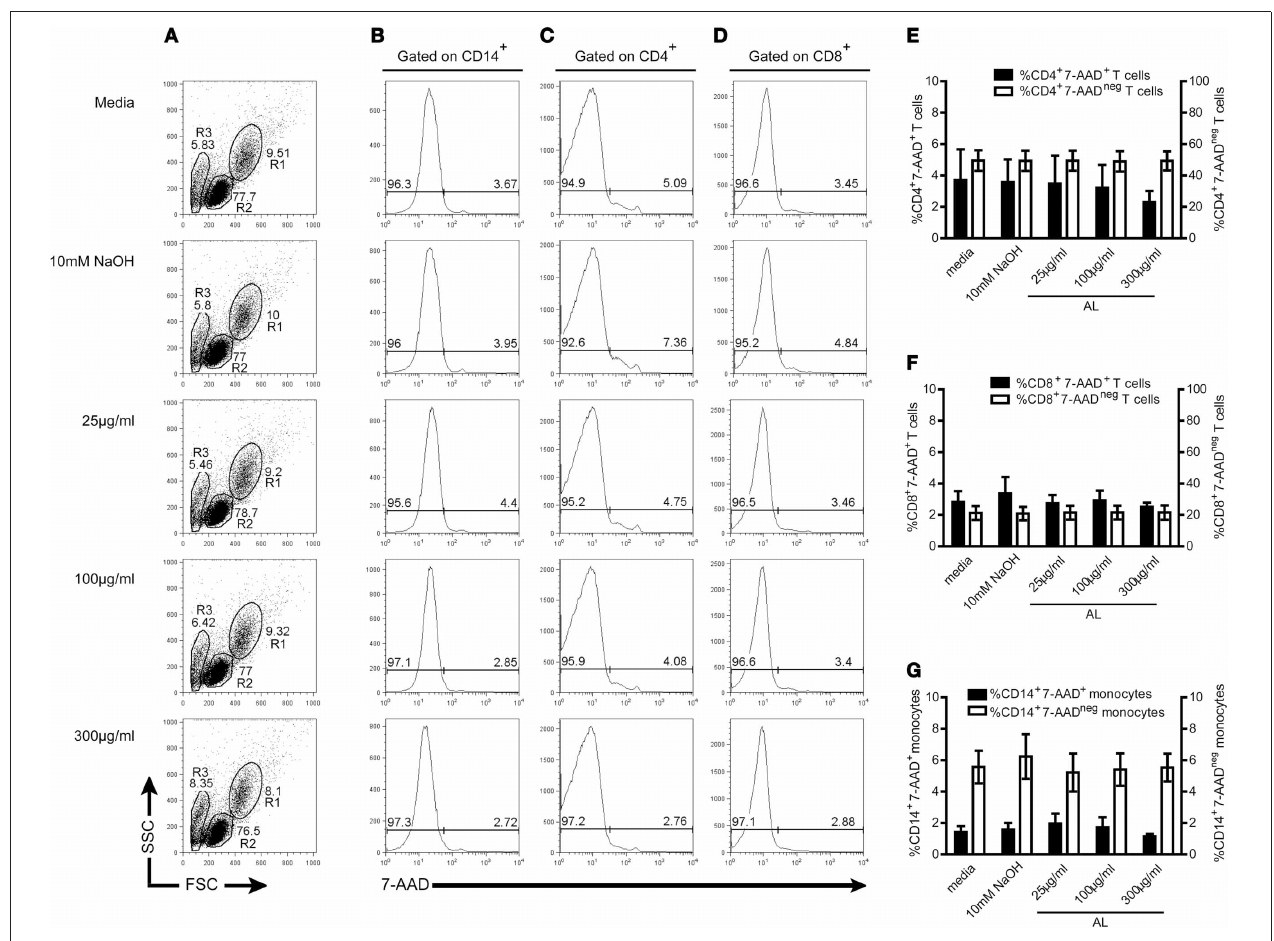
FIGURE 1 | In vitro treatment with allopurinol exerts no cytotoxicity and has no influence on CD4, CD8, and CD14 constitutive expression. PBMC from healthy donors were isolated by density gradient centrifugation on Ficoll-hypaque. PBMC were incubated in the presence or absence of allopurinol (25–300 μ g/ml) or drug vehicle (10mM NaOH) during 48h and analyzed by four color flow cytometry. The frequency of total non-viable and viable CD14 + , CD4 + , and CD8 + cells were determined by staining with 1 μ g/ml 7-aminoactinomycinD (7-AAD) in combination with CD14 (FITC), CD4 (PE), and CD8 (APC) antibodies. (A–D) Representative gate selection and analysis for monocytes and T cells. Monocytes (R1) and lymphocytes